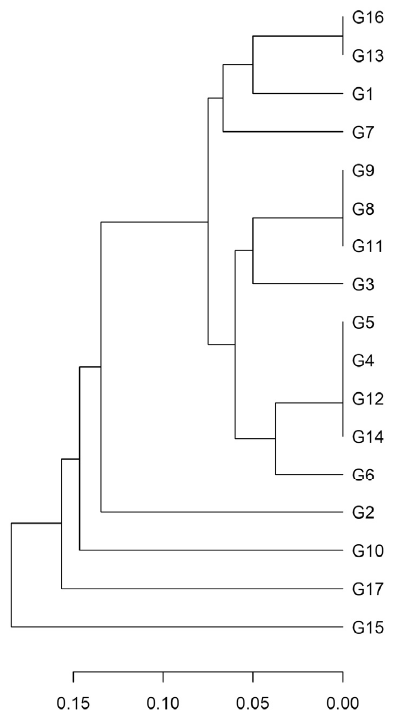
Plants 2023 , 12 , x FOR PEER REVIEW Figure 2. Dendrogram of the ‘Greco’ clones (G) based on their SSR profile. The dendrogram was built with the UPGMA algorithm using Provesti’s genetic distance (reported in the scale bar on the bottom).